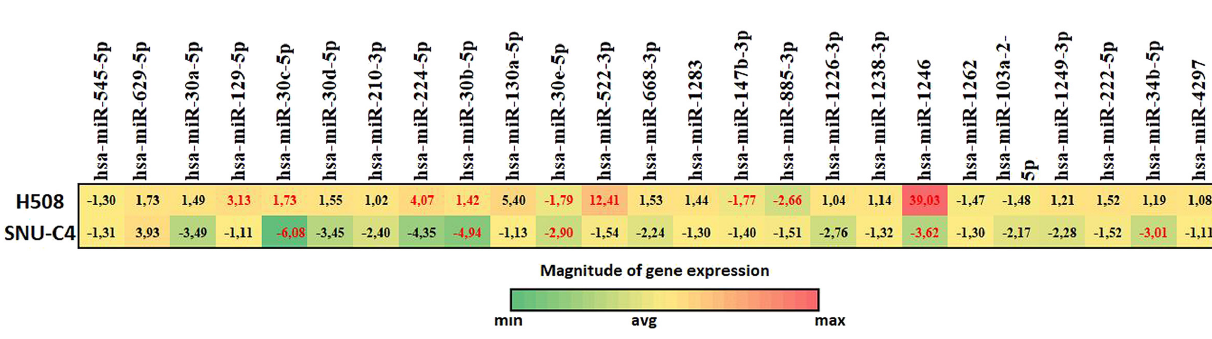
Figure 4. Effects of ST on miRNA expression compared with untreated (UT) H508 and SNU-C4 colon cancer cells. The magnitude of gene expression bar and the color range of minimum, maximum, and average fold change are shown in the bottom (red = upregulation; green = downregulation). The relative expression level of the miRs in each sample was normalized by the expression level of SNORD61, SNORD68, SNORD72, SNORD95, and RNU6-2 . Statistical analysis was performed with Student’s t -test. Values represent fold change. miRNA, micro RNA; ST, sodium taurolithocholate.